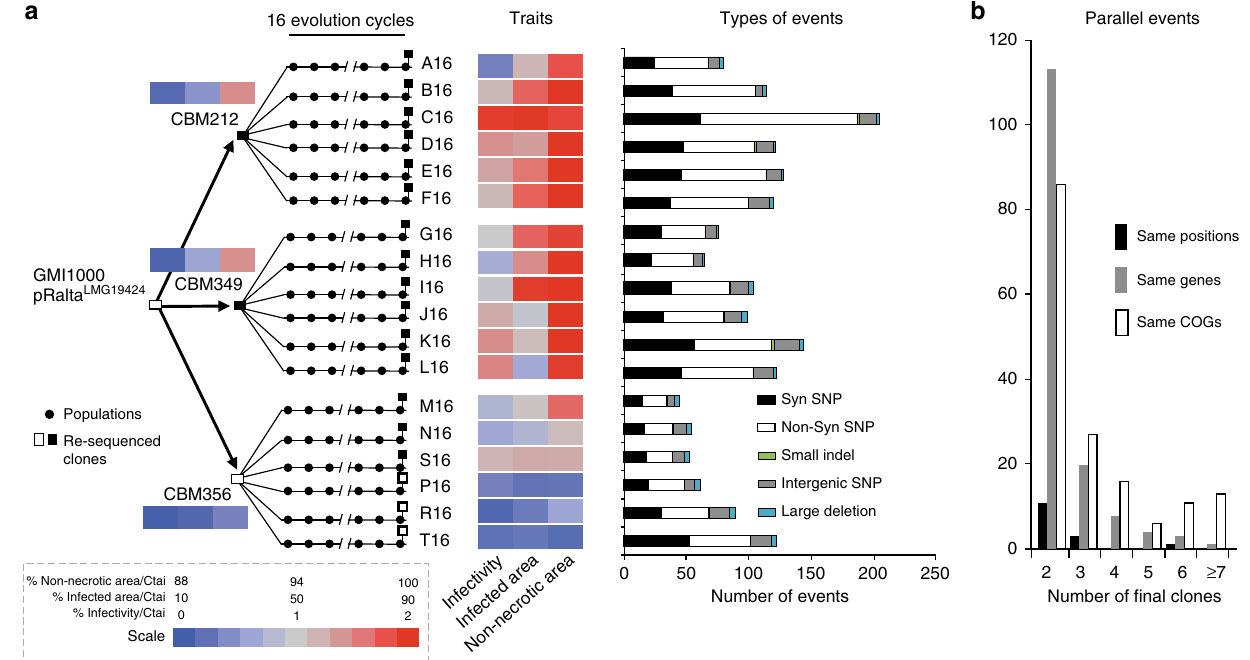
Fig. 1 Experimental evolution of Ralstonia and associated symbiotic and genomic changes. a An ancestral chimeric clone evolved to give origin to three clones able to nodulate M. pudica . These clones were then evolved in 18 independent lineages using 16 serial nodulation cycles. This process led to improved infectivity (number of viable bacteria recovered per nodule) and intracellularly infected area per nodule section and a decrease of necrotic area per nodule section (heatmap on traits). Except clones CBM356, P16, R16 and T16 (white squares), all acquired the ability of intracellular infection (black squares). The events identi fi ed at the end of the 16 evolution cycles for each lineage are indicated on the right (see list of deletions in Supplementary Table 1 and other mutations in Supplementary Data 1). b Black bars indicate the number of nucleotides mutated at the same position in two or more clones. Gray bars indicate the number of genes mutated in two or more clones. White bars indicate the number of COG functions with mutations in two or